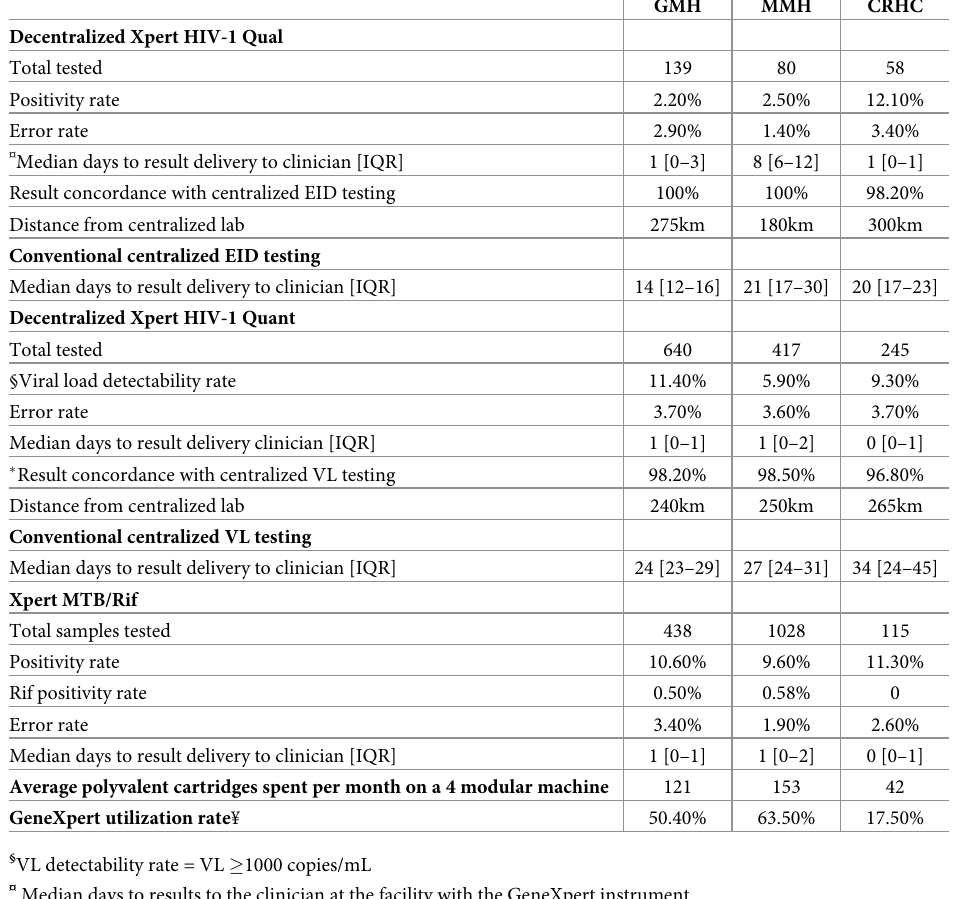
Table 2. Polyvalent testing (HIV-1 EID, HIV-1 VL and MTB/RIF) profiles at the three study